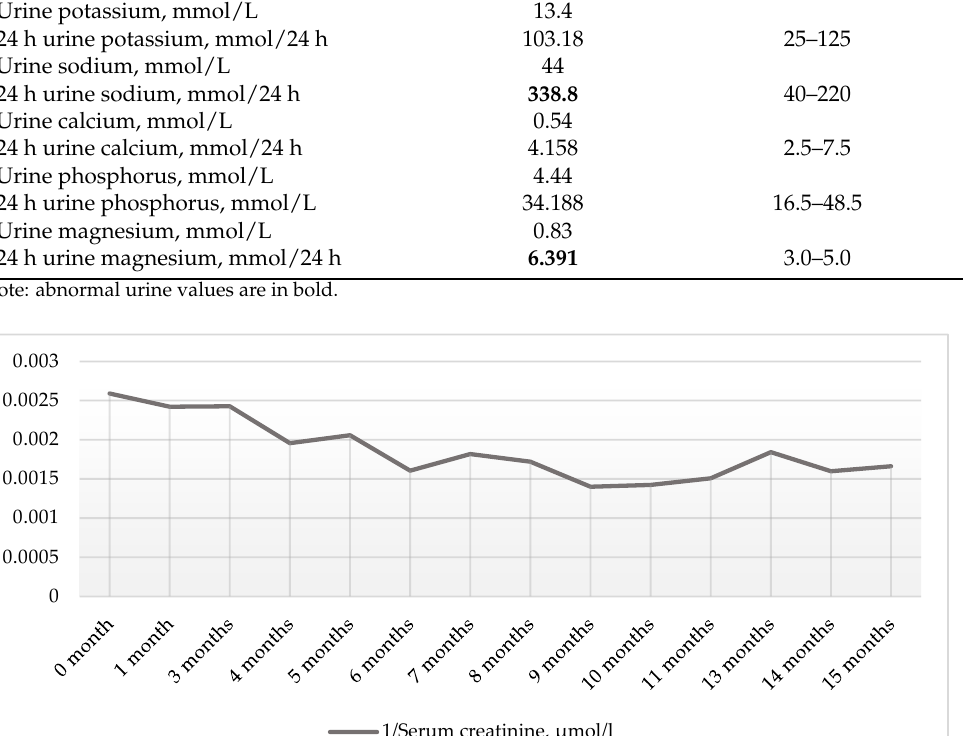
Figure 2. Family tree of the patient. Note: Arrow denotes the patient with Dent disease. Square represents male member, and circle represents female member. The quarter-filled square represents the patient’s brother with renal hypoplasia, whereas the quarter - filled circle represents the patient’s daughter with nephrocalcinosis.